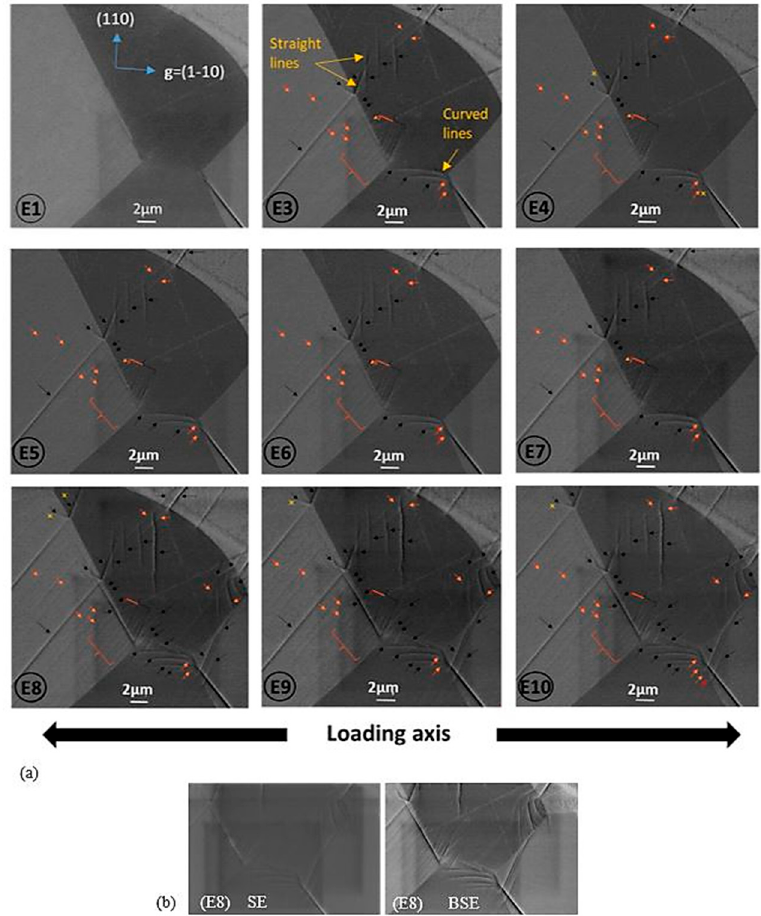
Figure 5. ( a ) BSE micrographs in channeling condition (with g = (1–10) in the grain of interest) presenting the evolution of the defect structure corresponding to each deformation step of the tensile curve. The letter refers to the zone (E) and the number refers to the load state from the curve. Black arrows indicate slip lines, orange arrows indicate dislocations and yellow crosses indicate an increase in dislocation length; ( b ) Example of SE vs BSE images from zone (E8).